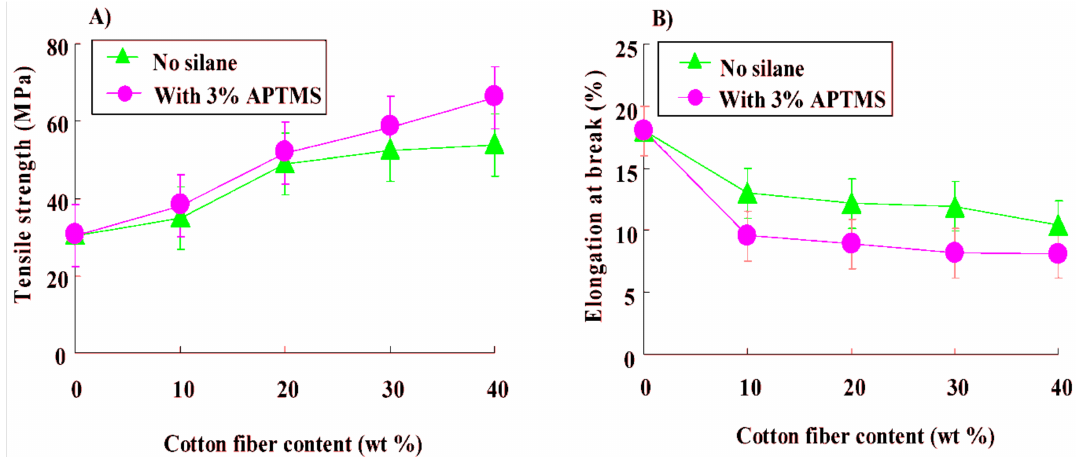
Figure 17. ( a ) Tensile strength and ( b ) elongation at break for PBS/cotton fiber (treated and untreated) [127]. Reprinted with permission from the publisher. Open